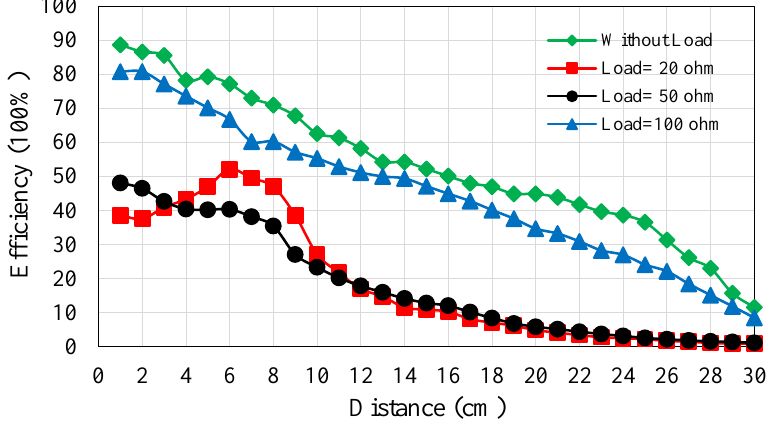
Figure 11. The relationship between transfer efficiency and transfer distance, with and without a load.